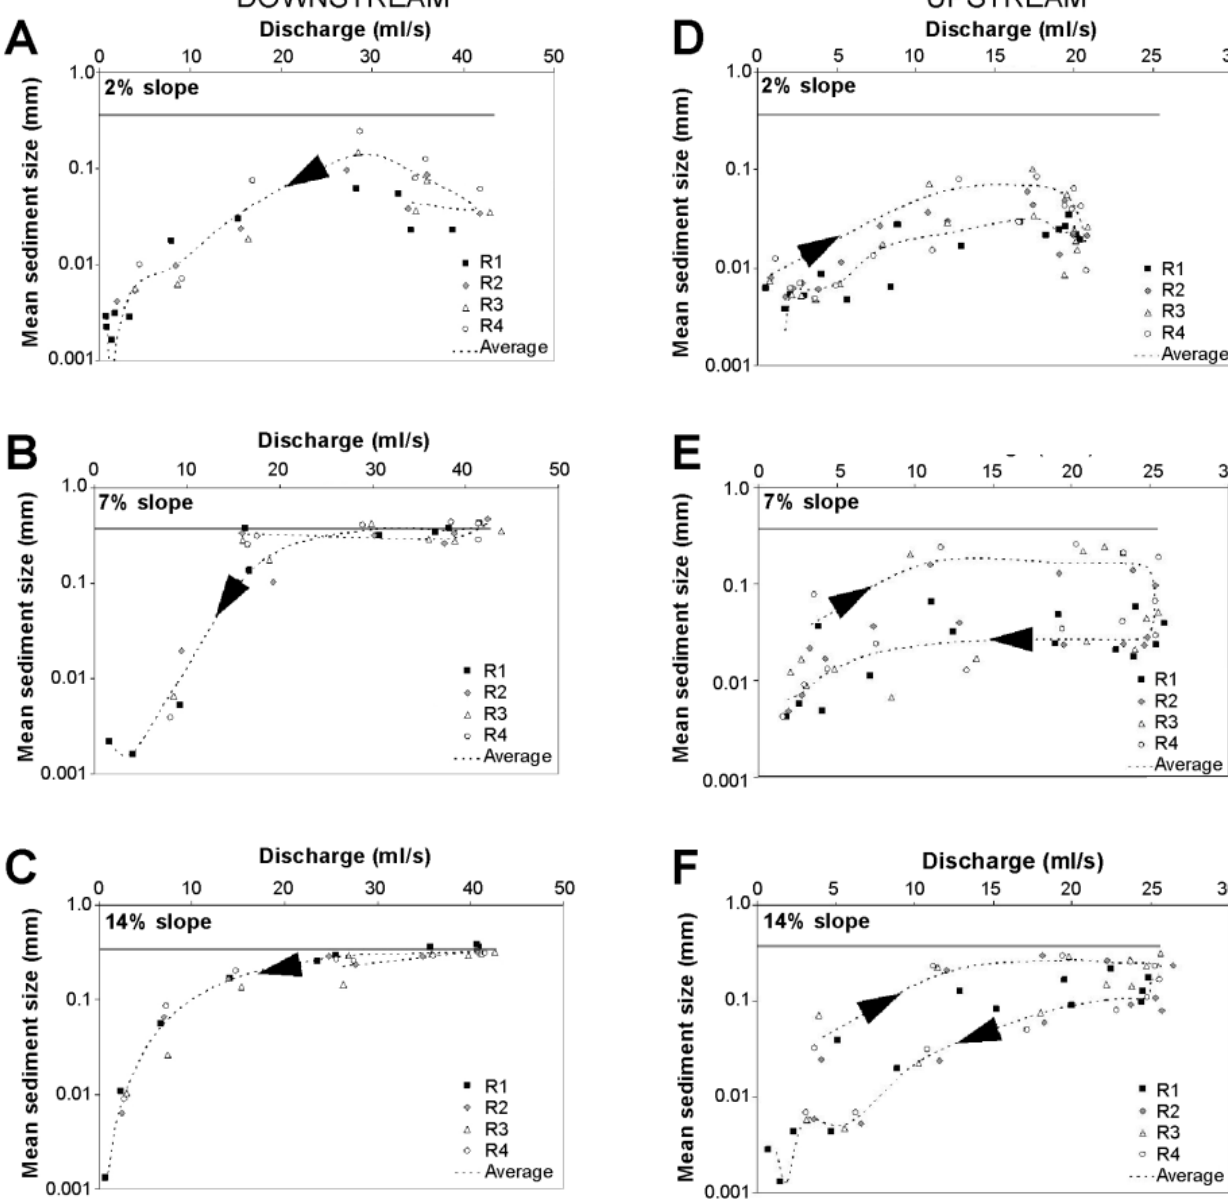
Fig. 4. Relationship between mean sediment grain-size and runoff discharge for 2%, 7%, and 14% surface gradients for downstream moving storms (left) and upstream moving fronts (right). The data are from four independent repetitions (R1, R2, R3, and R4). The horizontal grey line represents mean grain-size of the original soil. Arrow indicates grain-size evolution throughout the experiment. Note the different discharge scale for upstream and downstream moving storms.